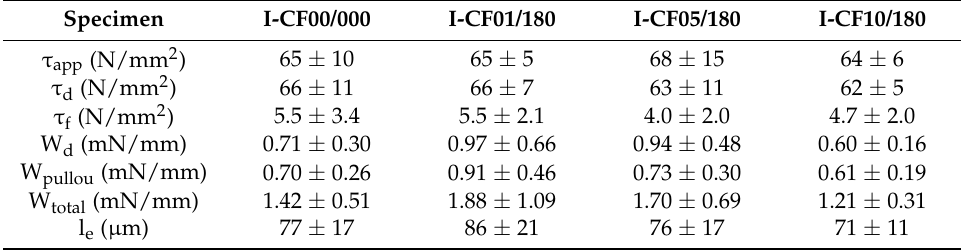
Table 5. Adhesion properties of reference and treated specimens, interfacial frictional shear stress as well as different pull-out